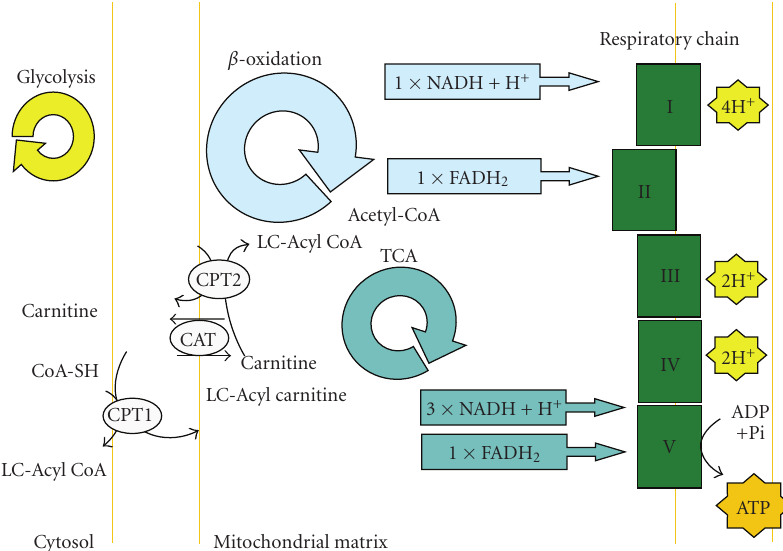
Figure 1: Mitochondrial biochemical pathways involved in energy production: including fatty acid oxidation, the respiratory chain, and TCA-cycle (Krebs-cycle) CPT1: Carnitine-Palmitoyltransferase 1; CPT2: Carnitine-Palmitoyltransferase 2; CAT: Carnitine-/Acylcarnitine- Transferase; LC: Long-chain; TCA: Tricarboxylic acid